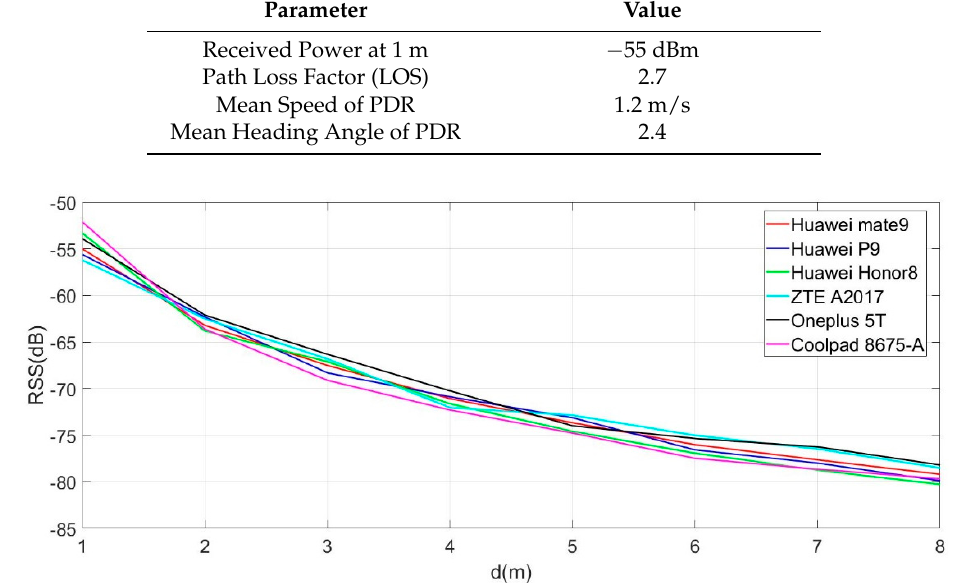
Figure 7. The received signal strength indication (RSSI) values at 1–8 m to BLE beacon collected by different phone models.